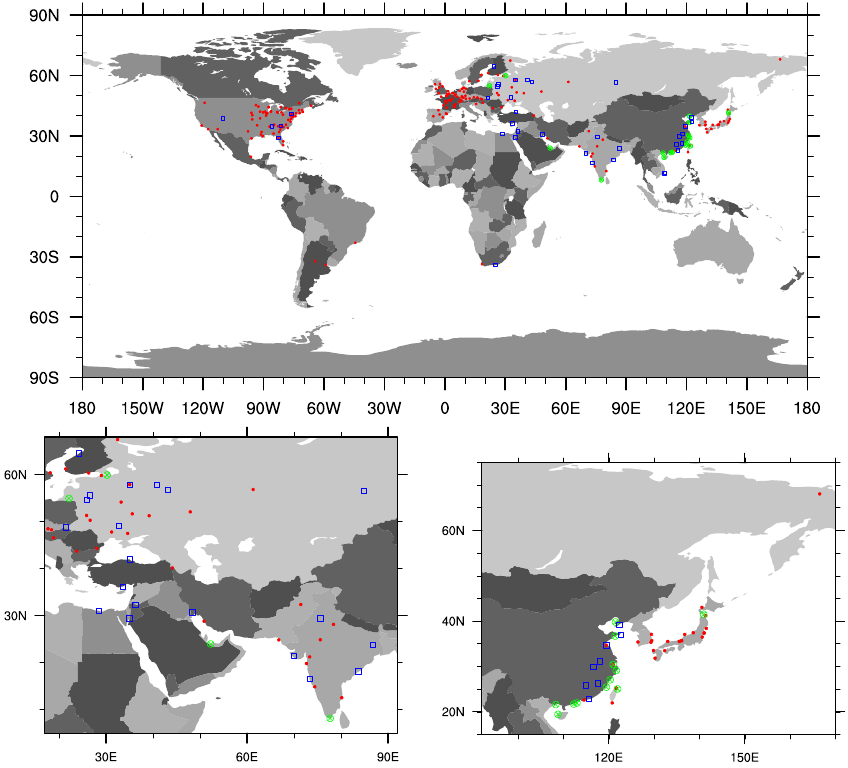
Fig.1. Geographicaldistributionofemissionsitescorrespondingtonuclearpowerplantsthatareoperational(redcircles),underconstruction (blue squares) and planned or proposed (green crossed circles). Source: World Nuclear Association (WNA) reactor database.